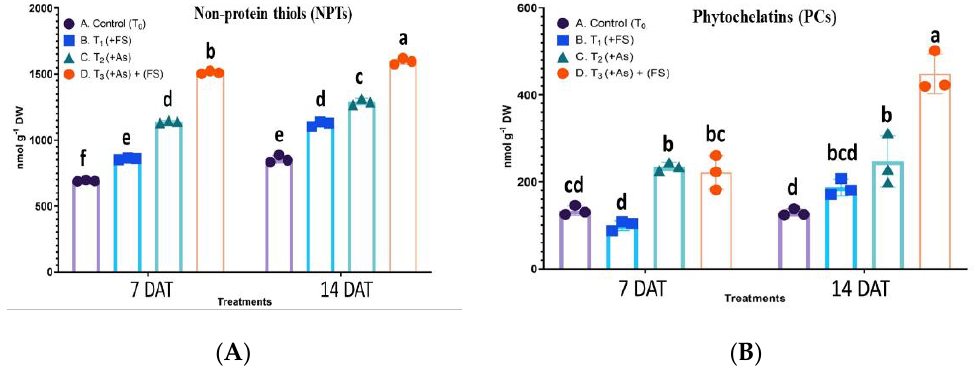
Figure 8. ( A , B ): Impact of iron sulfate (T 1 : +FeSO 4 ), arsenic stress (T 2 : +As) and iron sulfate supplementation during As stress (T 3 : As+FeSO 4 ) on non-protein thiols content (NPTs, 8 A ) and phytochelatins (PCs, 8 B ) content in the leaf of Brassica juncea studied 7 and 14 days after treatment (DAT). The values are mean ± SE and n = 3. Different letters on the bars indicate significant changes ( p < 0.05) in different treatments as determined by Tukey’s HSD test. As, Arsenic; FS, FeSO 4 .